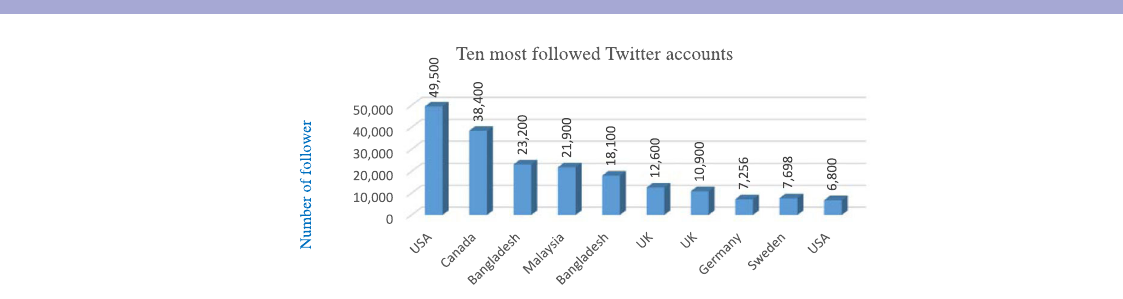
Table 2 Membership pattern in ten most popular Rohingya Twitter